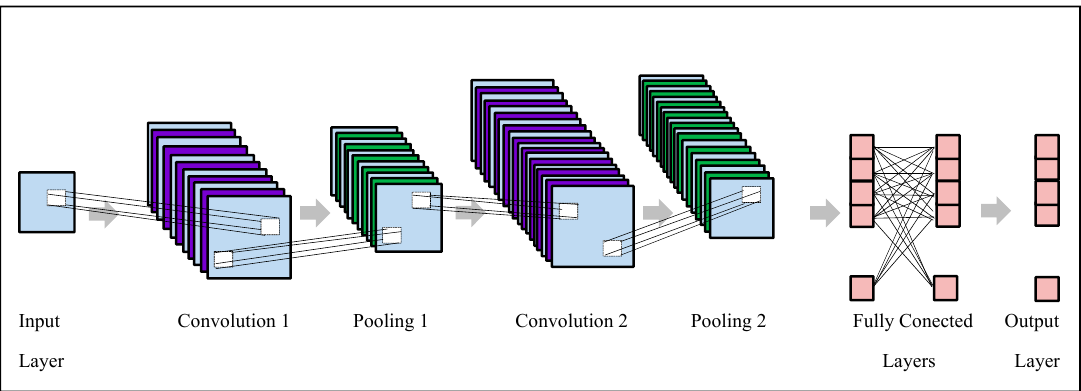
Figure 8. The architecture framework of a convolutional neural network [53].